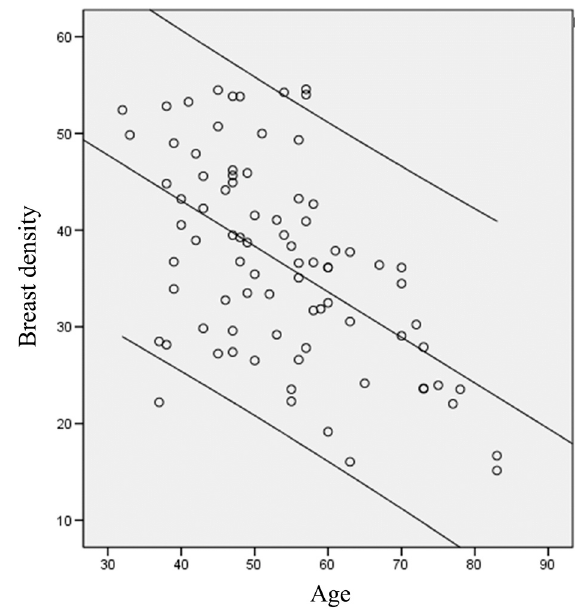
Figure 2. Relationship between age and breast density.